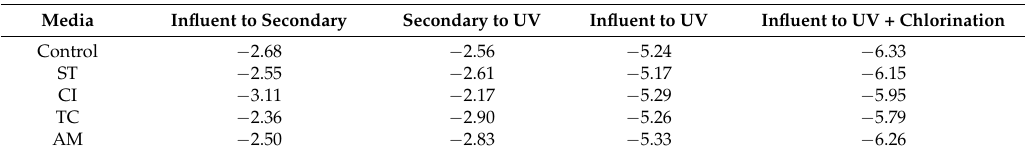
Table 2. Log removal of Escherichia coli in different treatment stages.